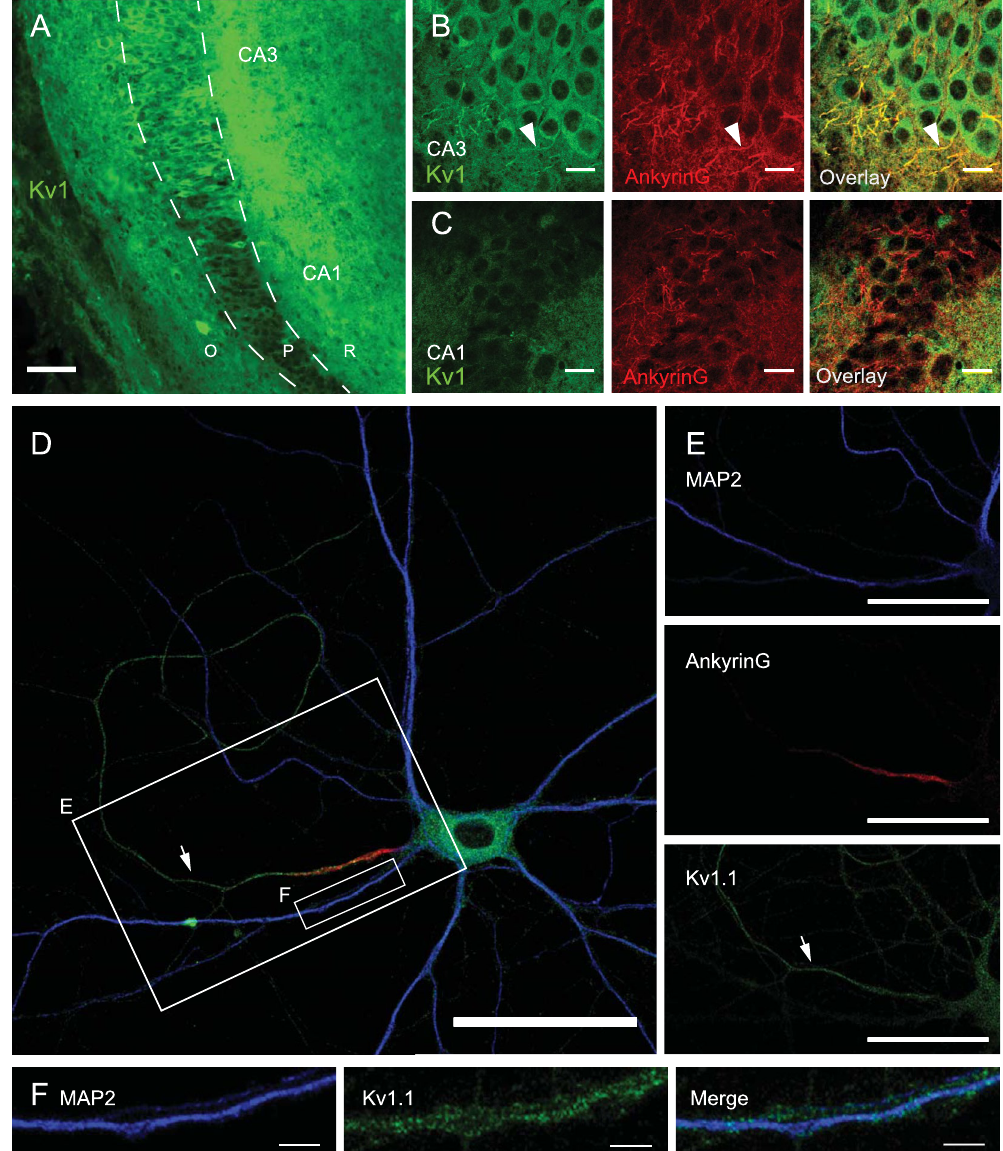
Figure 1. Kv1.1 channels are enriched in AIS area of CA3 pyramidal cells. ( A ) General view of an organotypic culture immunostained for Kv1.1 channels. Note the lack of Kv1.1 immunostaining in CA1 and the strong staining in CA2 and CA3. O, P, R: Oriens, Pyramidale & Radiatum areas. ( B ) Staining of CA3 area with Kv1.1 antibodies (left), ankyrin G antibodies (middle) and superimposition of both (right). Note the strong staining of cell soma with Kv1.1 antibodies and the staining of an extension from soma (left panel, arrowhead). Ankyrin G antibodies stain the AIS (middle panel, arrowhead), co-localised with Kv1.1 staining (right panel, arrowhead). ( C ) Representative views of CA1 area stained with Kv1.1 antibodies (left), Ankyrin G antibodies (middle) and superposition of both (right). Kv1.1 antibodies do not stain any particular structures and are not present in the cell bodies of pyramidal cells (left). Superposition of Kv1.1 and Ankyrin G staining does not show any co- localisation (right). ( D ) 19 DIV hippocampal neuron immunostained with the somatodendritic marker MAP2 (blue), the AIS marker AnkyrinG (red) and Kv1.1 (green) revealing a strong staining in the axon (arrowhead). ( E ) Detail of the area showed in ( D ). Note the Kv1.1 staining all along the axon (arrows). ( F ) Detail on a dendrite showed in ( D ), to show the lack of colocalization between MAP2 (left) and Kv1.1 (middle) staining. Right: composite image with both stainings. Scale bars: 20 µ m ( B,C ), 50 µ m ( A,D,E ) 0.2 µ m ( F